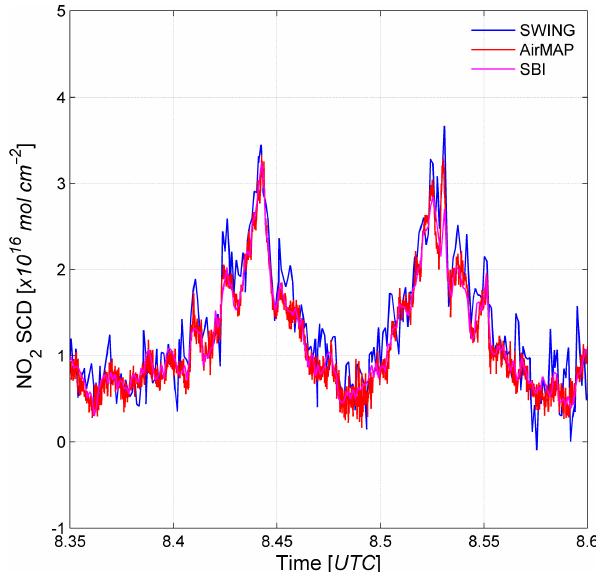
Figure 4. Zoom on the NO 2 SCD time series of the morning flight over Berlin on 21 April 2016, between 08:21 and 08:36UTC. The two NO 2 peaks correspond to the crossings of the main plume with an east–west